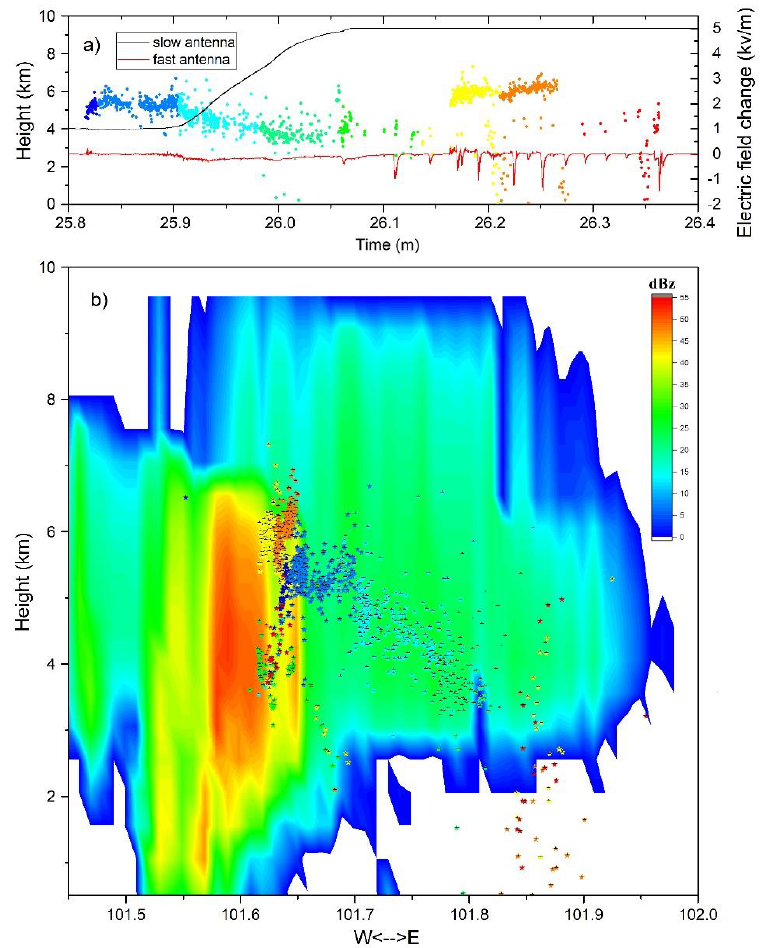
Figure 11. Fast and slow electric field change waveforms of negative ground flash No. 134925 and the positioning results of the VHF radiation sources compared with the radar echo. ( a ) Height-time plots and electric field change waveforms; ( b ) North-Southward vertical projection superimposed by vertical section of radar